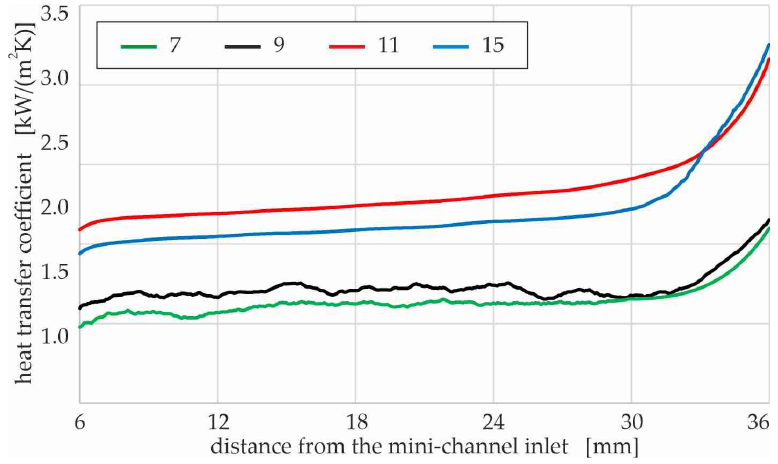
Figure 14. The heat transfer coefficient versus the distance from the mini ‐ channel inlet, assuming four different numbers of mini ‐ channels in the test section, i.e., 7, 9, 11, and 15, according to numerical simulations in Simcenter STAR ‐ CCM+ software.